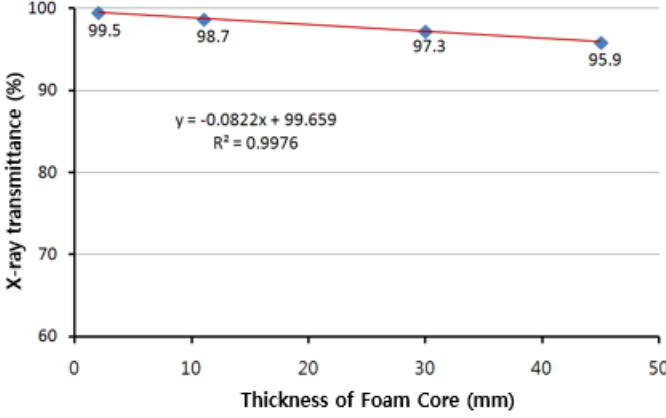
Figure 3. X-ray Transmission ratios of core material.